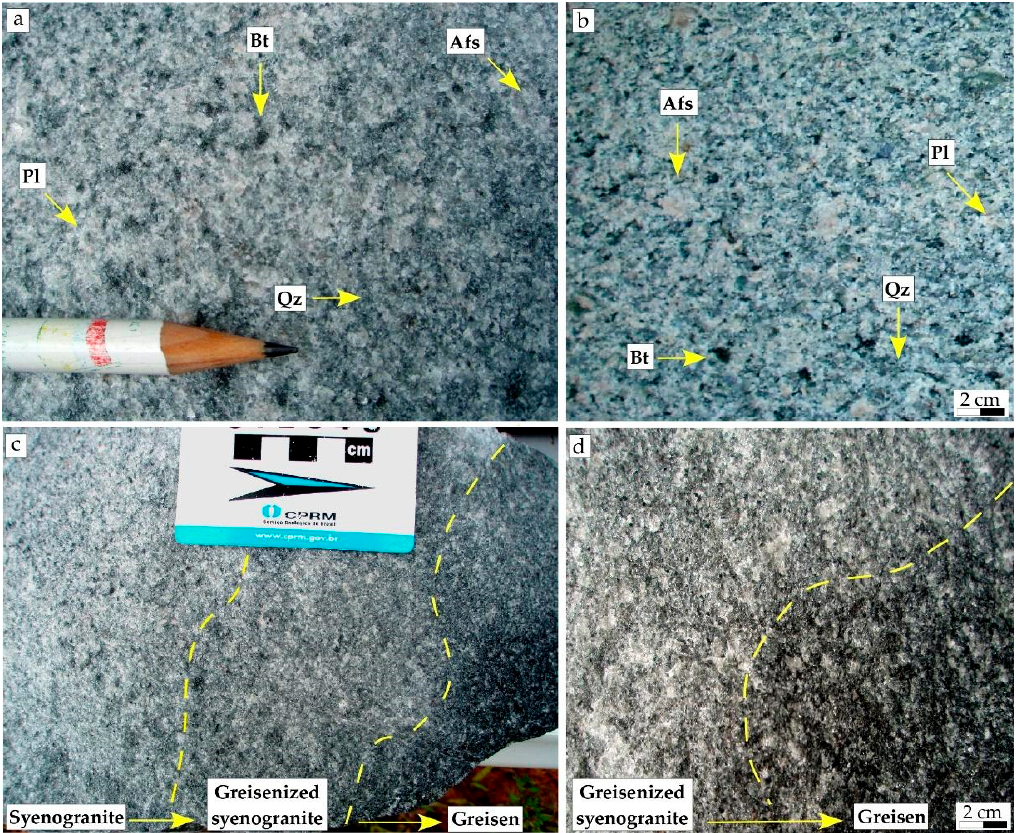
Figure 2. Macroscopic aspects of the Desemborque rocks. ( a ) Massive, fine-grained, leucocratic, grey-colored of the main syenogranite, showing equi- to inequigranular texture defined by quartz (Qz), plagioclase (Pl), and alkali feldspar crystals (Afs), as well as biotite (Bt) as the main mafic mineral; ( b ) porphyritic syenogranite showing rounded and / or tabular alkali feldspar in a fine-grained matrix of quartz, plagioclase, and interstitial biotite; ( c ) contacts between the main syenogranite with the greisenized granite and greisen rocks; ( d ) the detail of contact between greisenized syenogranite and greisen. Note the darker-colored aspect and the finer-grained texture of these rocks relative to the main biotite syenogranite.